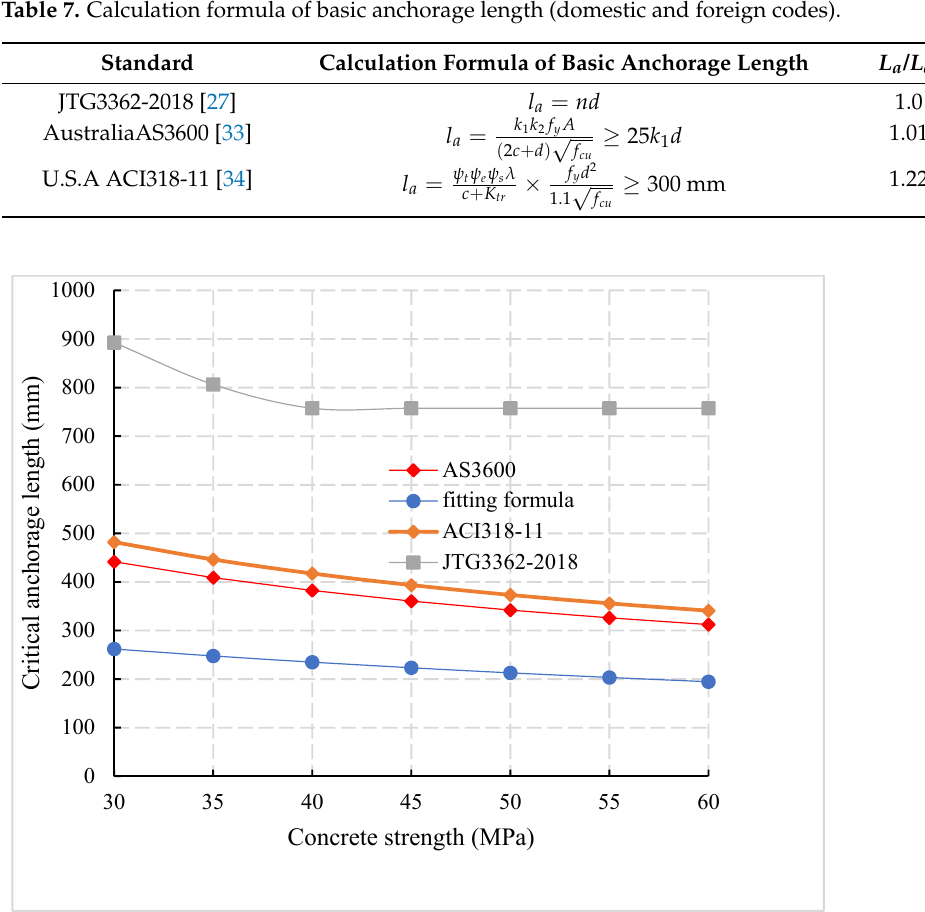
Table 8. Comparison of anchorage length between domestic and foreign codes.